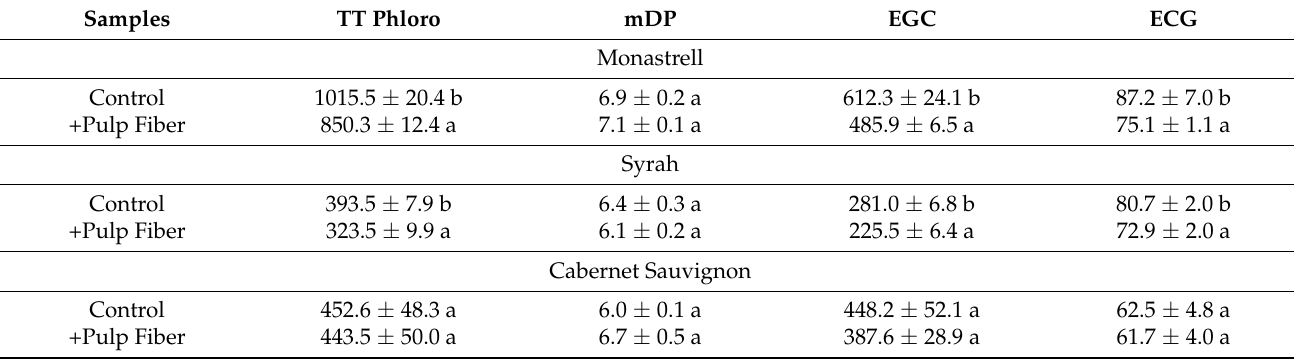
Table 3. Concentration and composition of tannins of wines with and without treatment with the fining agent (pulp